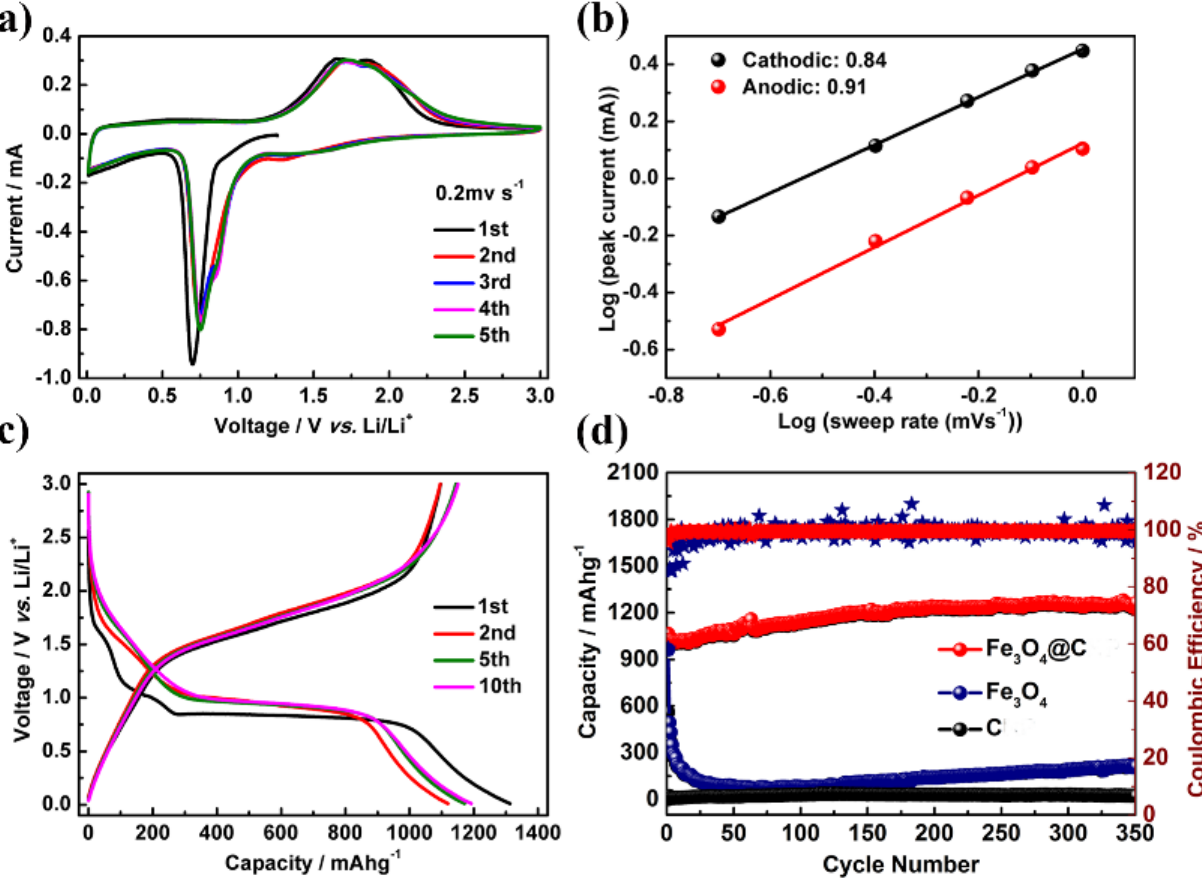
Figure 5. ( a ) The first five CV curves of Fe 3 O 4 @C electrode at a scan rate of 0.2 mV s −1 ; ( b ) b value determined based on the dependence of the peak current on the scan rate; ( c ) GCD profiles of Fe 3 O 4 @C electrode at 0.1 A g −1 ; ( d ) cycling stability and CE of different electrodes at 0.1 A g −1 .